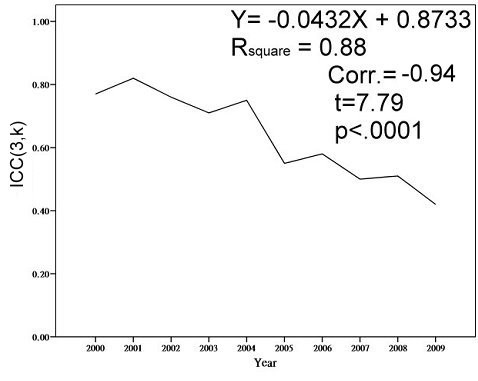
ICC decreased over time from 0.77 in 2000 to 0.42 in 2009.